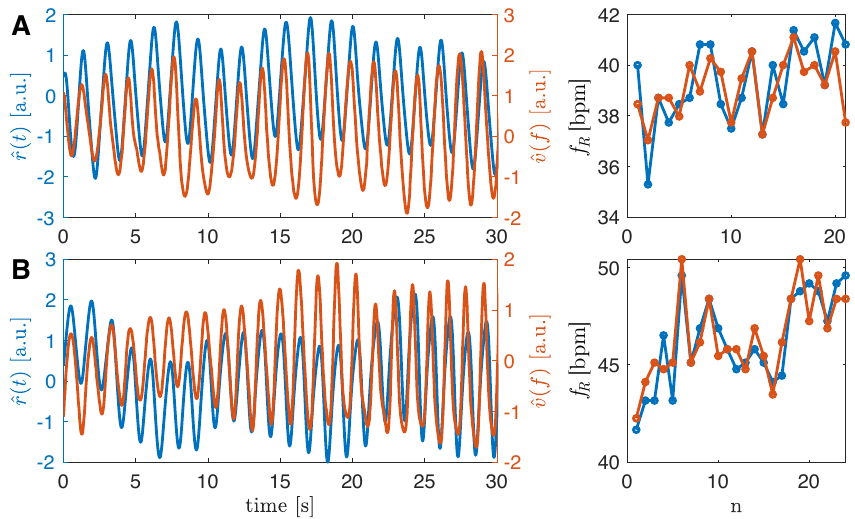
Figure 6. Two patterns collected from two volunteers simulating tachypnea. In blue, the reference signal ˆ r ( t ) , in orange the ˆ v ( f ) signal. In the first volunteer ( graphs A ), the average ˆ f R is 39.14 bpm while the average f R is 39.34 bpm. In the second volunteer ( graphs B ), the average ˆ f R is 46.44 bpm while the average f R is 46.28